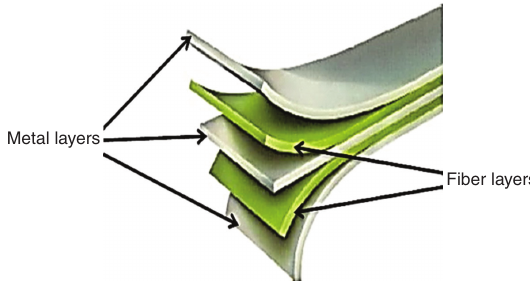
Figure 1 A sample of FML lay-up.